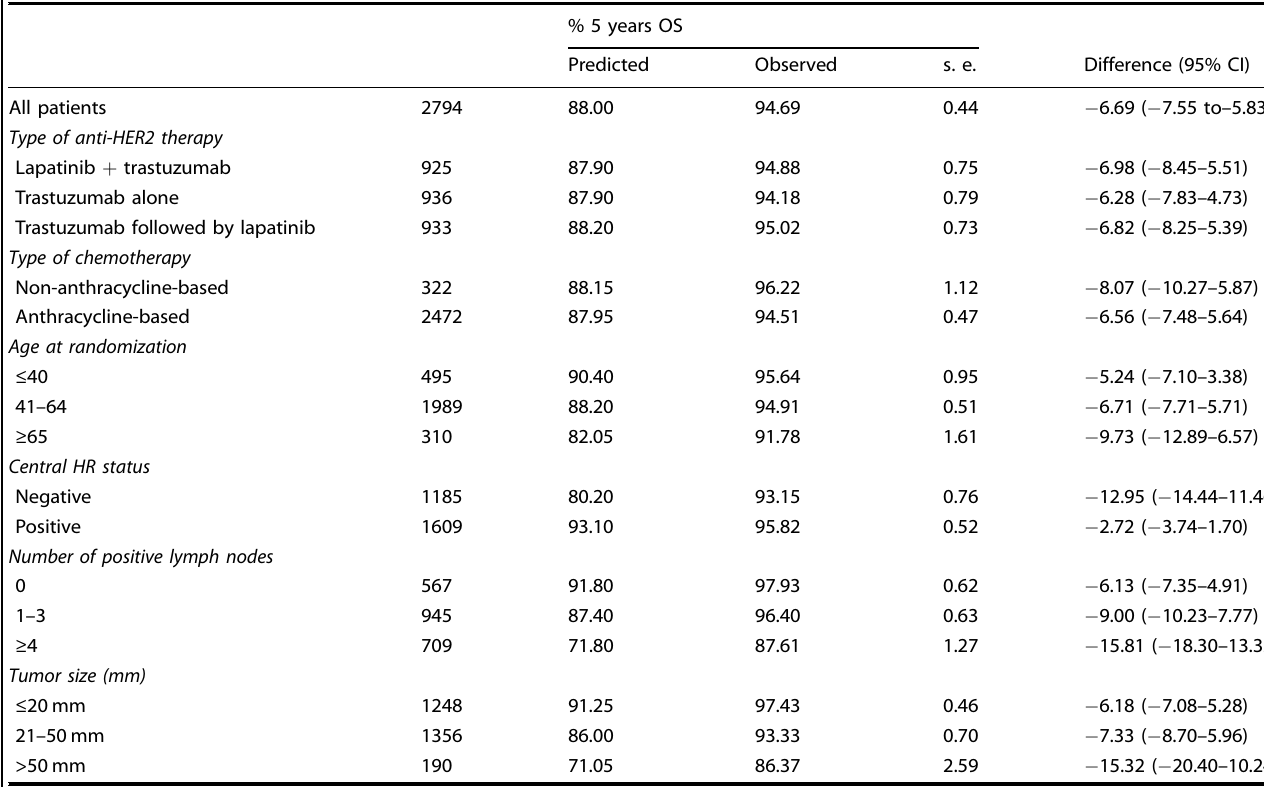
Table 2. Median predicted probability of 5-year overall survival and observed 5-year overall survival rate in the study population.